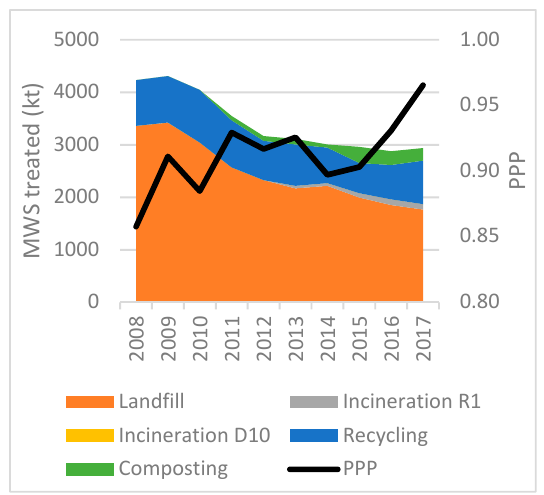
Figure 5. Population and MSW production in Czech Republic 2008–2017 (EUROSTAT 2019a, 2019c). Soc. Sci. 2019 , 8 , x FOR PEER REVIEW